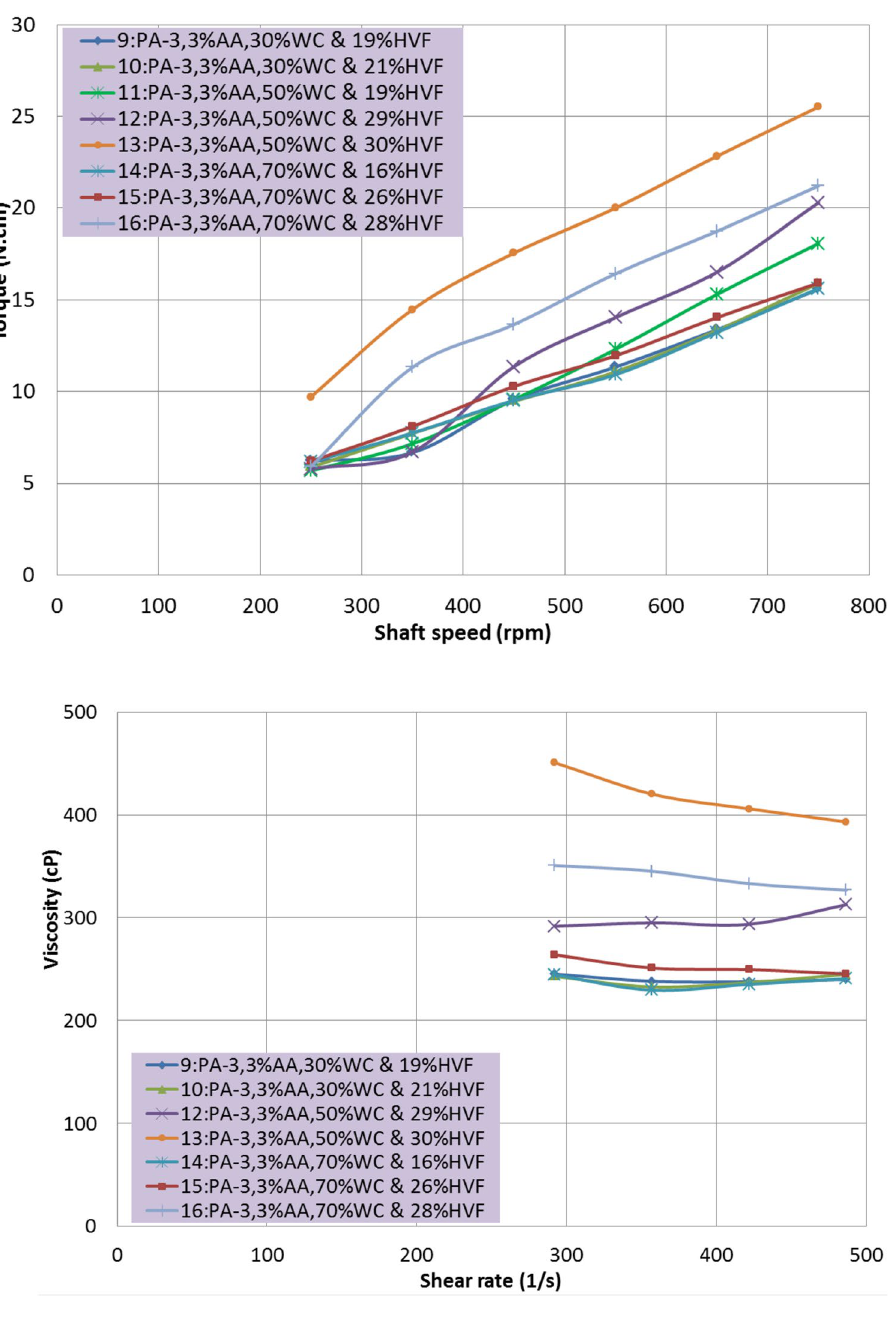
Fig. 15 Average torque values collected from Zone IV for kerosene tests. AA anti-agglo- merant, WC watercut, HVF hydrate volume fraction